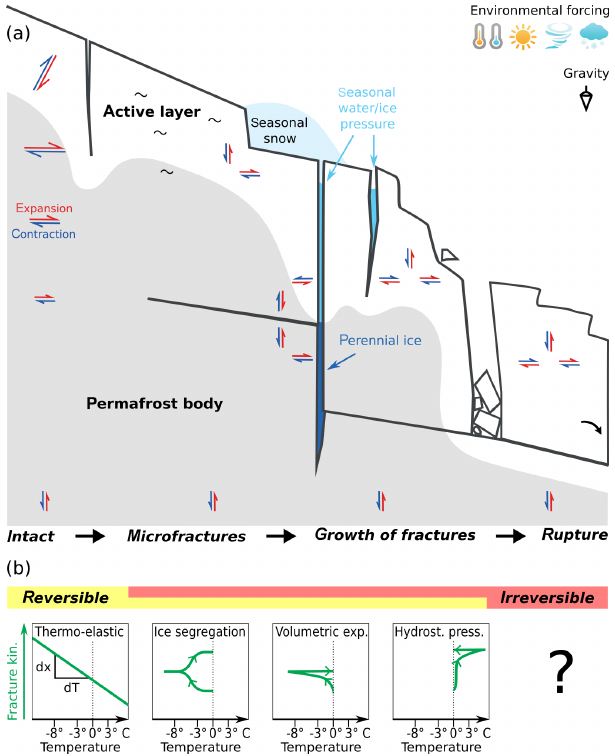
Figure 1. Schematic visualization of kinematics in steep, fractured bedrock permafrost shows the main acting mechanisms influenced by varying environmental forcing. (a) The gray area indicates per- mafrost, which is thermally defined as ground with a temperature below 0 ◦ C for at least 2 consecutive years. The overlaying active layer is exposed to subannual freezing and thawing. (b) The indi- cated mechanisms can lead to fracture kinematics and each isolated mechanism causes specific movement patterns, illustrated with the schematic plots showing the relation between fracture kinematics and rock